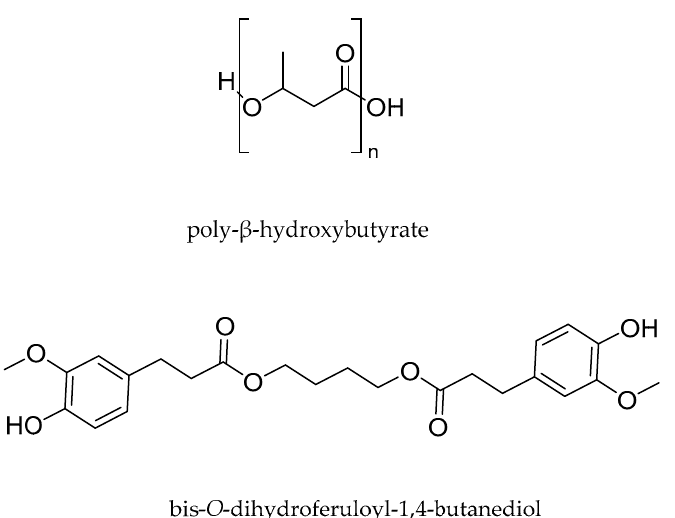
Figure 1. Structures of PHB and BDF.